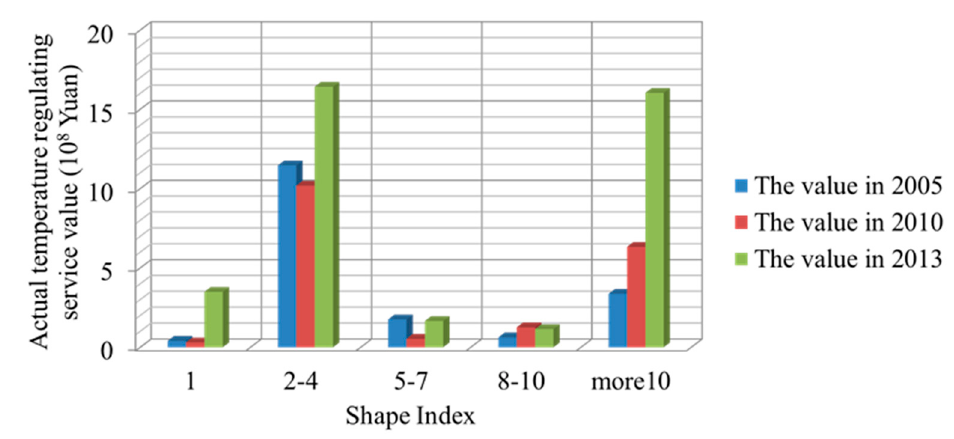
Figure 6. Actual temperature regulating service value of “source” landscape in 2005, 2010, and 2013 with different shape indexes.